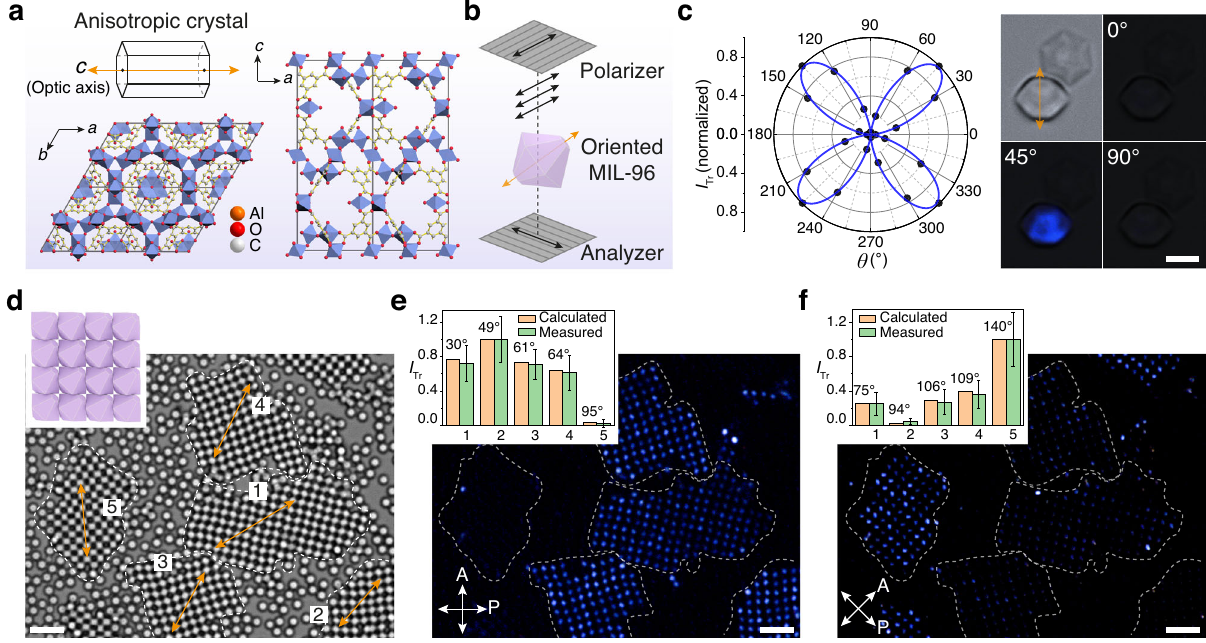
Fig. 6 Birefringent 2D fi lms of anisotropic MIL-96. a Molecular structure of MIL-96 along c and b axes ( a-b plane and a-c plane). The optic axis ( c axis) is shown by orange double arrow. Orange, red, and gray spheres represent aluminum, oxygen, and carbon atoms, respectively. Al octahedra are shown in blue. b Observation of birefringence using polarized light microscopy with crossed polarizer/analyzer (gray grating). The black double arrows show the polarization direction after light passes through the polarizer or analyzer. The transmission light intensity ( I Tr ) is recorded every 15° by rotating the crossed polarizer/analyzer pair. c Plot with fi tting of the normalized I Tr as a function of θ , angle between light polarization and MOF ’ s optic axis (projected on x – y plane). Bright- fi eld and polarized optical images of 5.1- µ m MIL-96 particles at θ = 0, 45, and 90°. MIL-96 particle standing by its (101) face exhibits typical birefringence of a uniaxial crystal; the one standing by the (002) face is always dark. d Bright- fi eld optical image and cartoon of MIL-96 fi lms assembled from 1.8- µ m particles. The superlattice grains are circled by dotted line and labeled by their orientation (orange double arrows). e , f Crossed-polarized microscope images show birefringence of the superlattice grains in ( d ) at polarization angles of 0° ( e ) and 45° ( f ). Angle of each crystal grain with respect to polarization direction is measured and the theoretical intensities are calculated, which agree with the measured I Tr (normalized) values (charts, insets). Scale bars: 3 µ m ( c ) and 5 µ m ( d – f